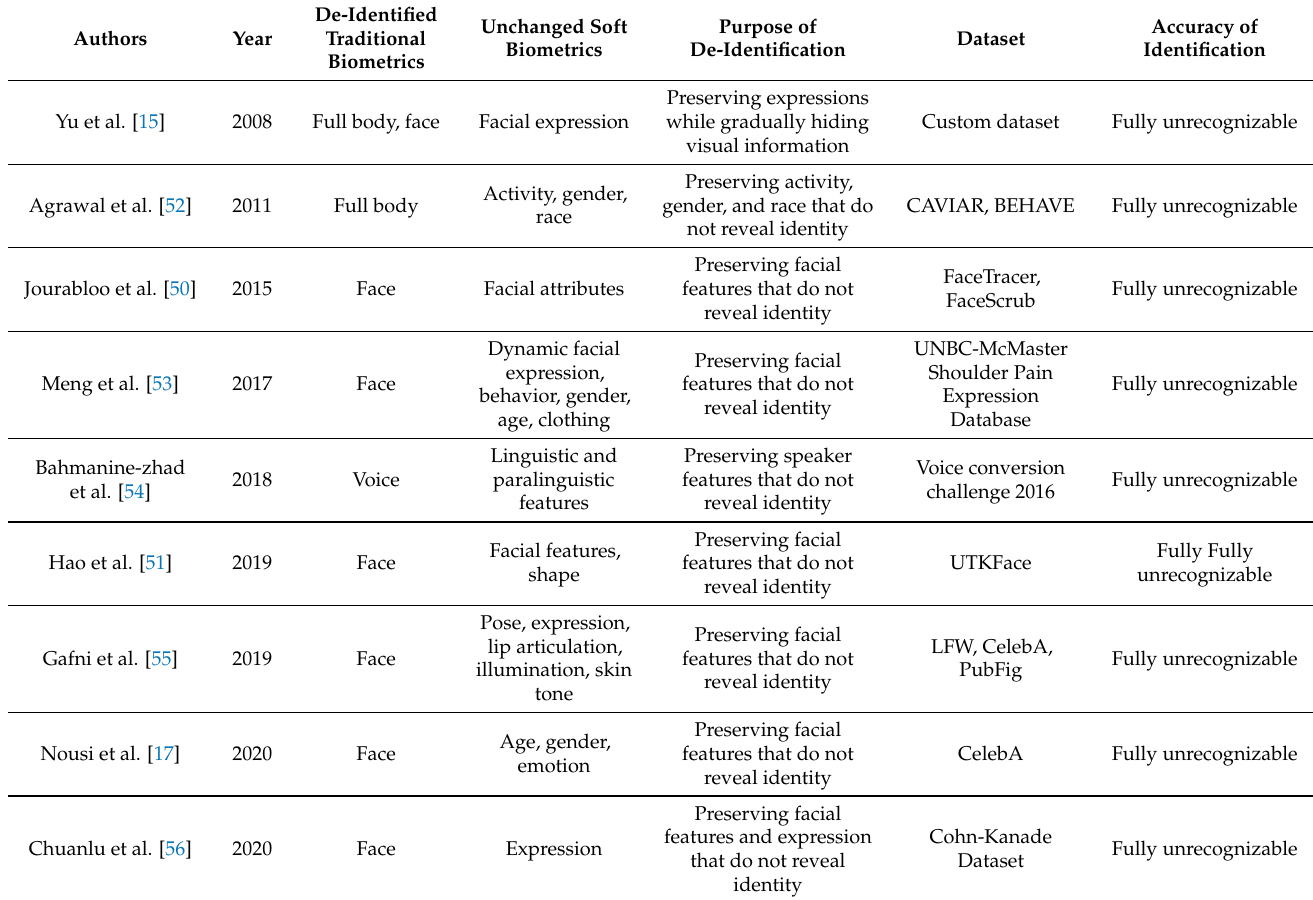
Table 3. Summary of soft biometric preserving utility retained de-identification